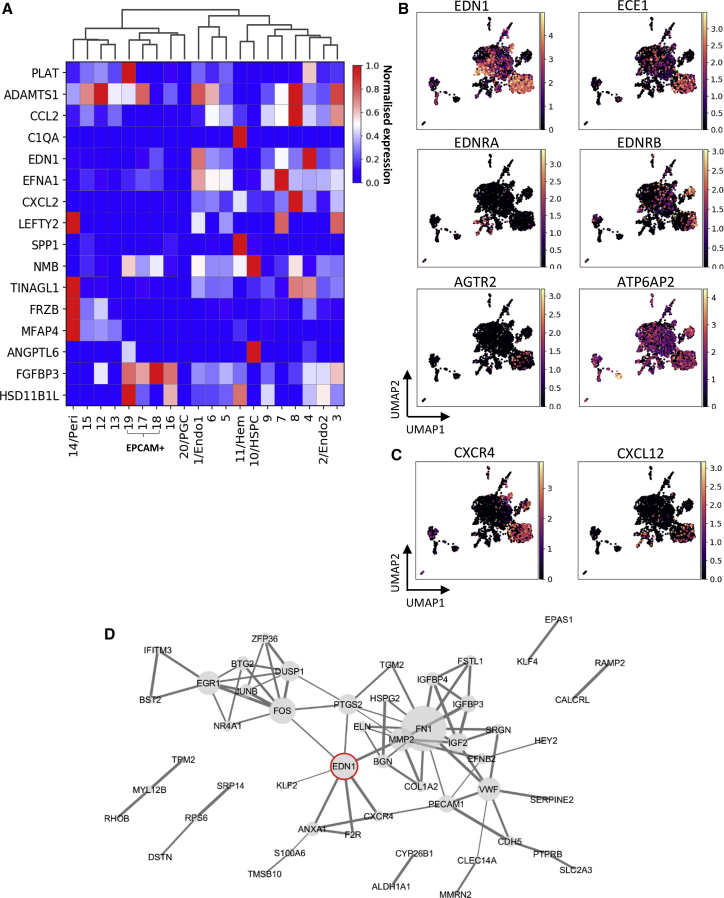
Mapping LCM-Seq Niche Signals to Cell Populations in the AoV Suggests Autocrine and Paracrine Signaling of Endothelin 1(A) Expression of differentially expressed secreted factors detected in the V_Inner and V_Mid subdomains (LCM-seq1) in cell CLs shown in Figure 4B.(B) Mapping expression of endothelin and renin core pathway genes on the CS16 AoV single-cell dataset (the plot is ln normalized).(C) Mapping expression of CXCR4 and CXCL12 to cell CLs shown in Figure 4 (the plot is ln normalized).(D) StringDB network of high-confidence known and predicted interactions between genes expressed in arterial CL1, including direct protein-protein physical and indirect functional associations (confidence > 0.7). The size of a node indicates the number of connecting edges. The width of a line indicates confidence of the interaction; confidence levels = 0.4–0.9.